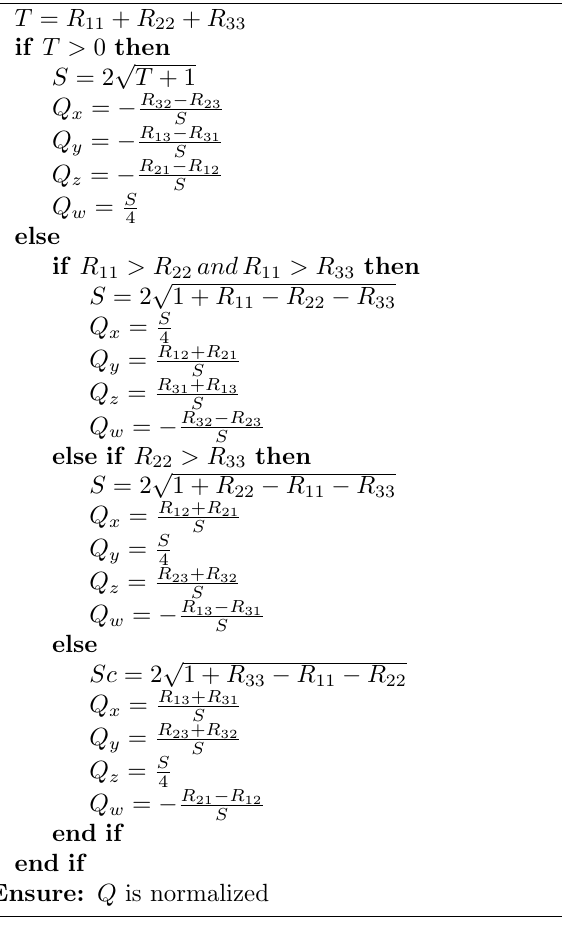
Algorithm 1 Matrix-quaternion conversion